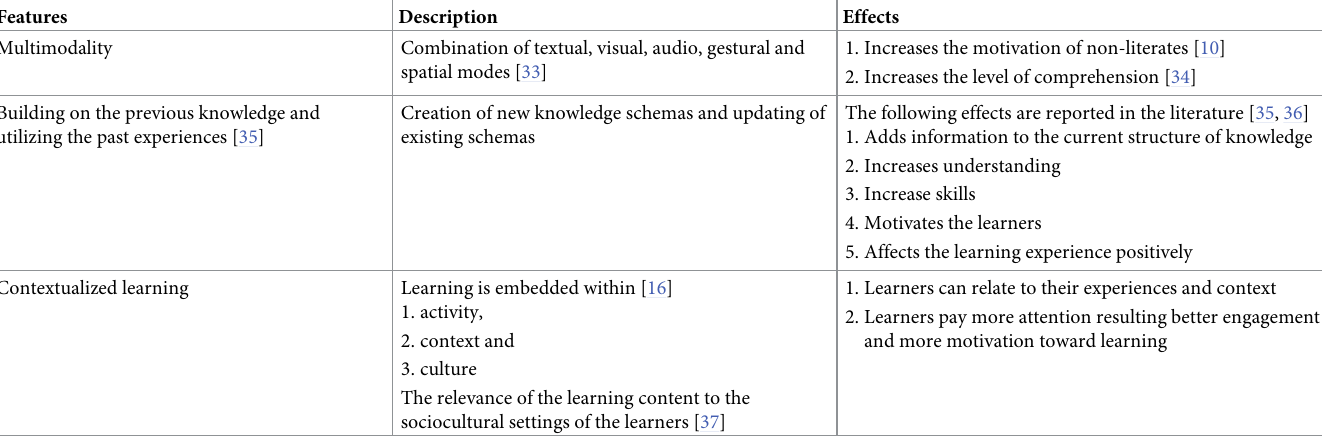
Table 1. Features for designing the learning content for non-literates.